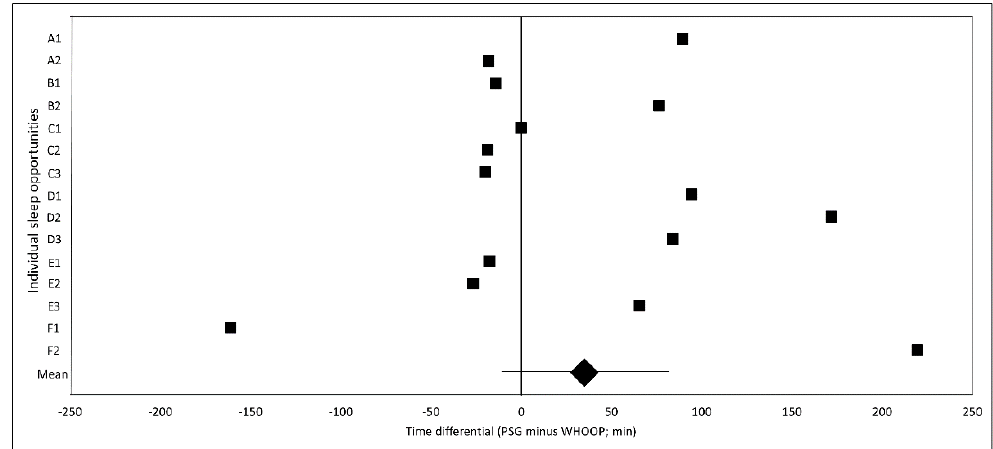
Figure 4. Time differential (min) for SWS periods derived by PSG and WHOOP. Data are presented as WHOOP time of day minus PSG time of day such that positive values indicate WHOOP-derived SWS periods occurred after PSG-derived SWS periods. Diamond marker represents mean bias ±95% confidence interval. Y-axis letters represent individual partic- ipants. Y-axis numerals represent individual participants’ sleep opportunities. min, minutes; PSG, polysomnography; SWS, slow-wave sleep.